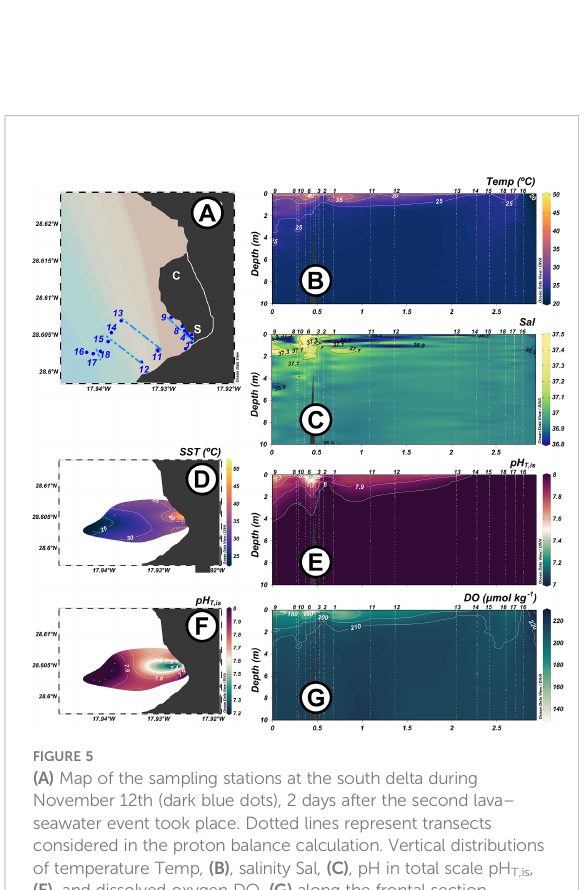
FIGURE 5 (A) Map of the sampling stations at the south delta during November 12th (dark blue dots), 2 days after the second lava – seawater event took place. Dotted lines represent transects considered in the proton balance calculation. Vertical distributions of temperature Temp, (B) , salinity Sal, (C) , pH in total scale pH T,is , (E) , and dissolved oxygen DO, (G) along the frontal section (stations 1 – 9) and along the surrounding waters (stations 10 – 18) and surface plots of temperature SST, (D) and pH T,is (F) .